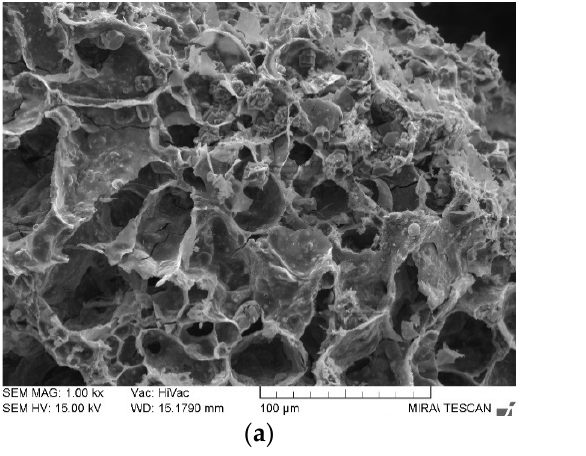
Figure 2. Microstructure of porous geopolymers: ( a ) IC-1SL-Q, ( b ) MK-1SL-Q